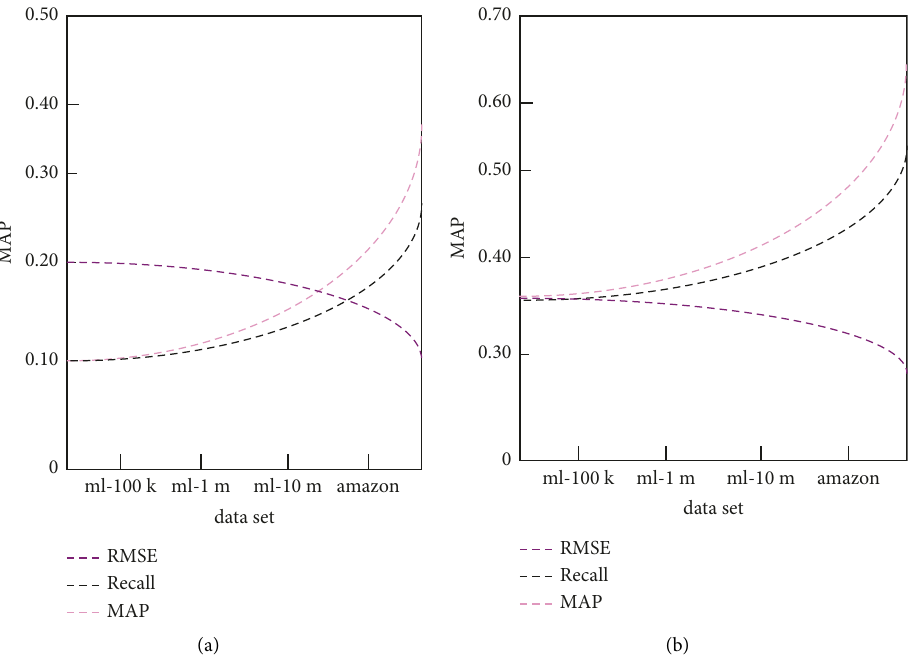
Figure 7: Comparison of different indicators of the deep neural network recommendation model before and after improvement. (a) Comparison of different indicators of the recommendation model before improvement. (b) Comparison of different indicators of the recommendation model after